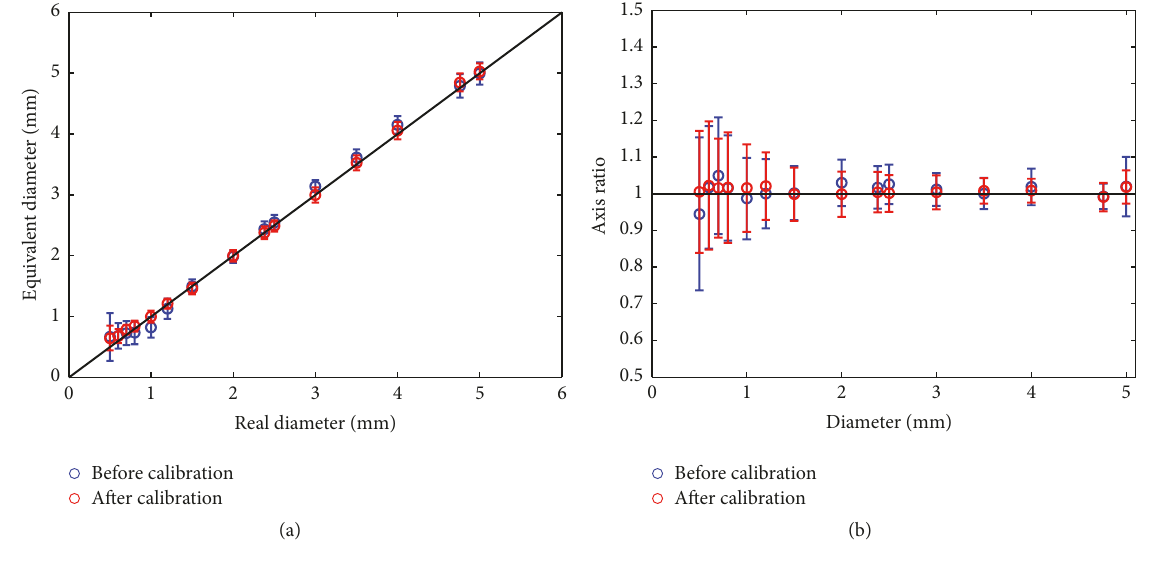
Figure 14: Evaluation of the performance of